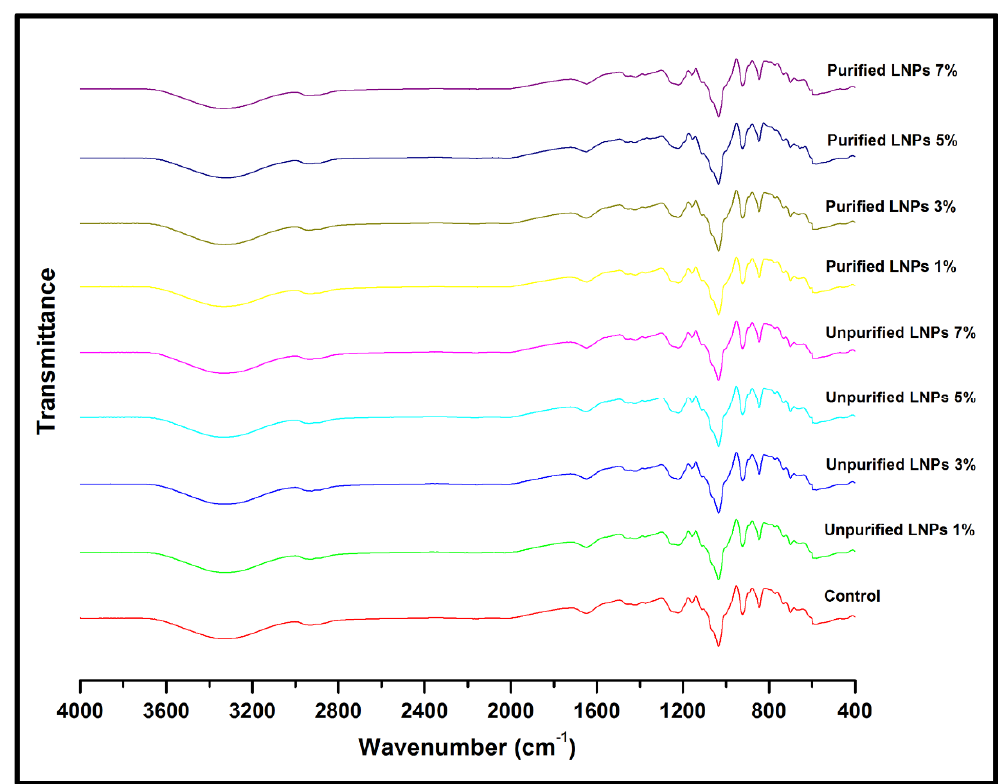
Figure 8. FT-IR spectra of macroalgae, control film and bioplastic films filled with unpurified and purified LNPs.